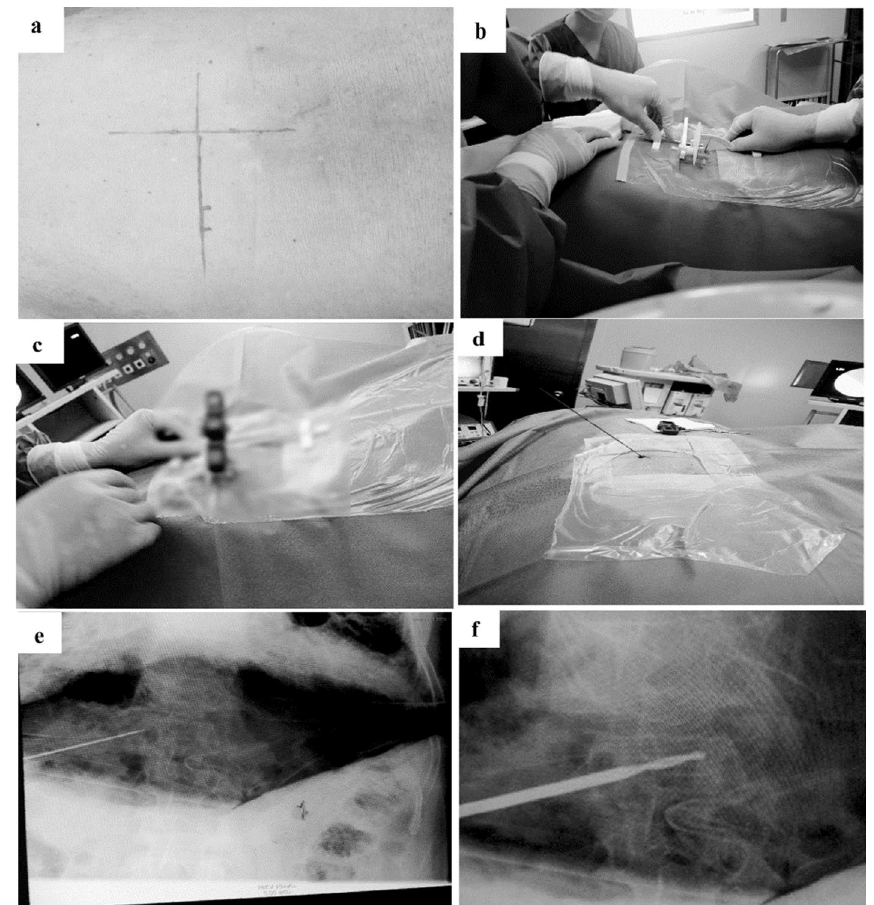
Figure 4. Percutaneous kyphoplasty by using the locator. Graph ( a ) shows that the patient was in the prone position. ML and HL lines, as well as the percutaneous puncture point “P” were marked according to the data acquired from the images preoperatively. Graph ( b ) illustrates that the locator was placed parallel to the ML line after adjusting for the positions of the hands on dials at the defined angles according to the preoperative measurement of extraversion angle α- and tail tilt angles β. Graphs ( c ) and ( d ) display that a cannula was placed in the locator, making the distal end of the cannula aligned with the puncture point “P”, and then, a guide needle was inserted into the cannula until the pedicle bone puncture point was planted into the pedicle. Graph ( e ) shows that the position of guide needle was confirmed by 2D fluoroscopy. Graph ( f ) depicts that a saccule was placed through the working channel and the fractured vertebral body was expanded with an appropriate pressure. Then, bone cement was injected into fractured vertebrae to stabilize the spine and relieve